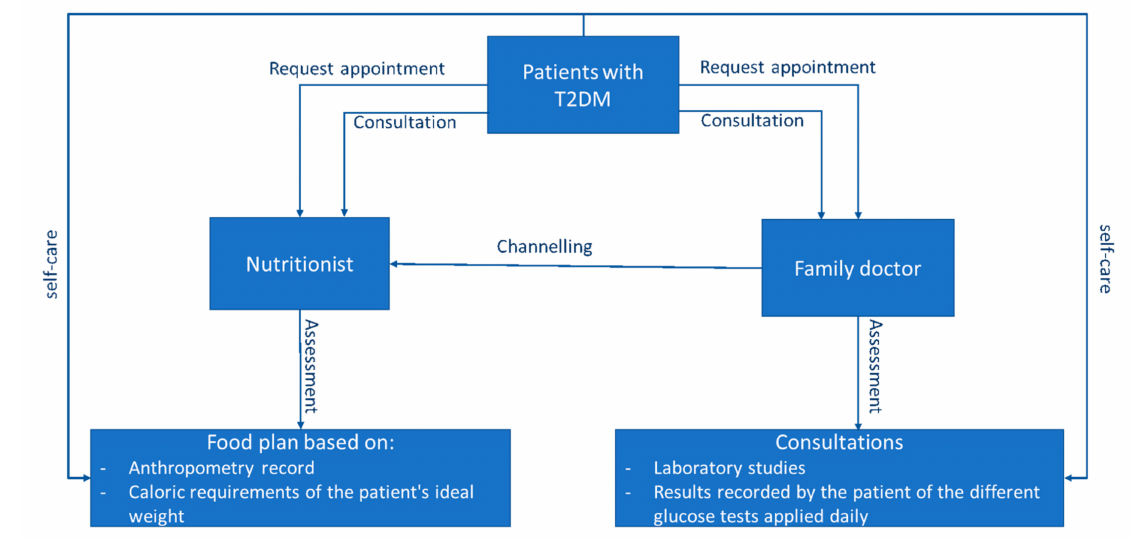
Figure 1. Patient care